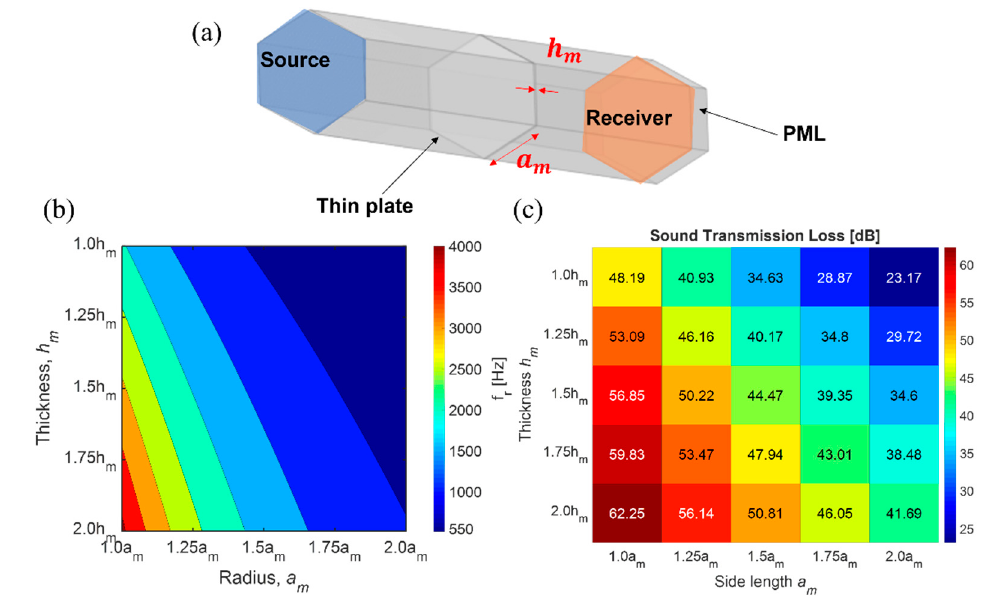
Figure 4. The result of the parametric study on design parameters, such as thickness, h m , and side length, a m , of the thin plate of the unit cell of AMSes; ( a ) the schematic image of the unit cell used in Figures 1 and 2; ( b ) the natural frequency of AMSes; ( c ) the average STL of AMSes from 100 Hz to 400 Hz calculated by the numerical simulation .